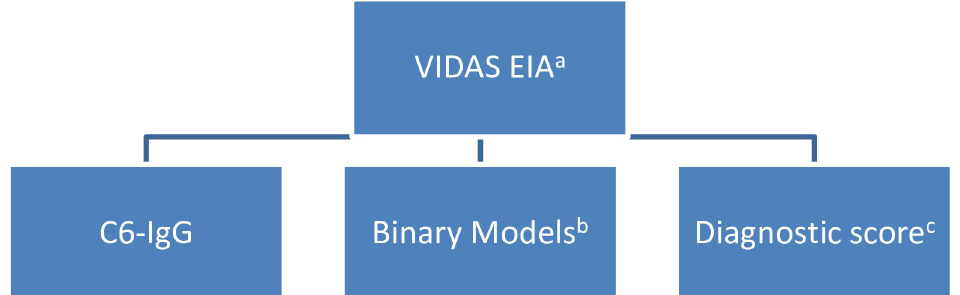
Fig 1. Testing algorithm for modified 2-tiered approaches to Lyme disease diagnosis. a Positive or equivocal VIDAS EIA results were confirmed by a second-tier EIA method. b See Table 2 for a complete list of binary antibody models evaluated. c Diagnostic score optimized as described above.